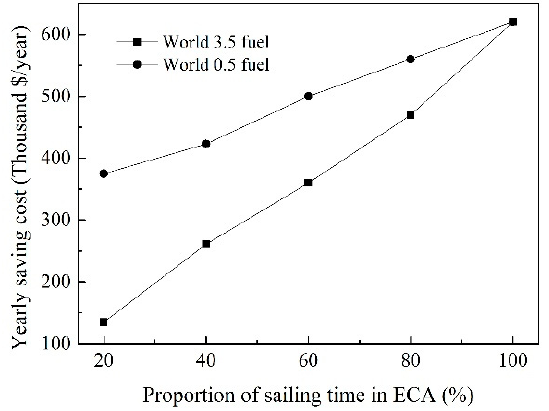
Figure 11. Relationship between yearly saving cost and sailing time in ECA with a scrubber.